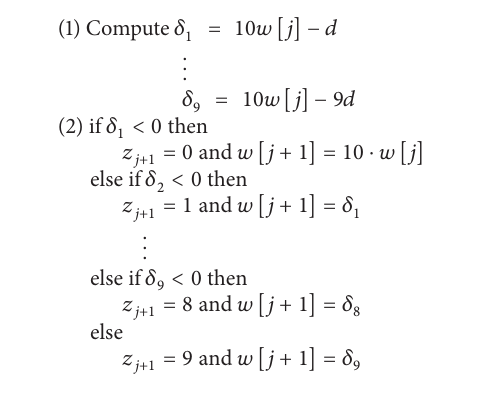
Algorithm 1: Pseudocode for type1 digit recurrence division.